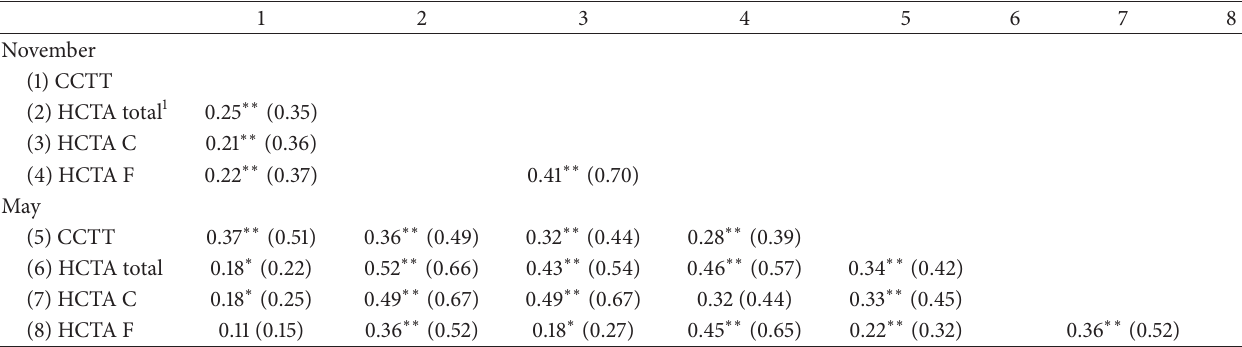
Table 9: Correlation between both tests in November and in May (with correction for attenuation).